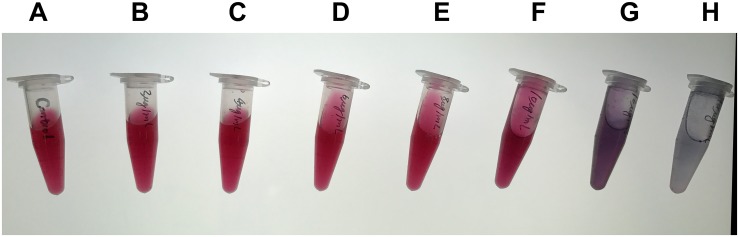
Optimization of the capture antibody concentration. Serial dilutions of purified capture antibody 7D7 were prepared containing 3, 4, 6, 8, 10, 12, and 14 μg/ml (B–H) and mixed with colloidal gold solution; colloidal gold solution alone served as a control (A).